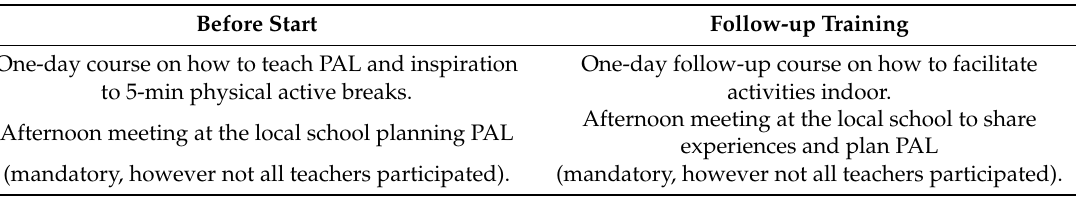
Table 1. PAL competence development of